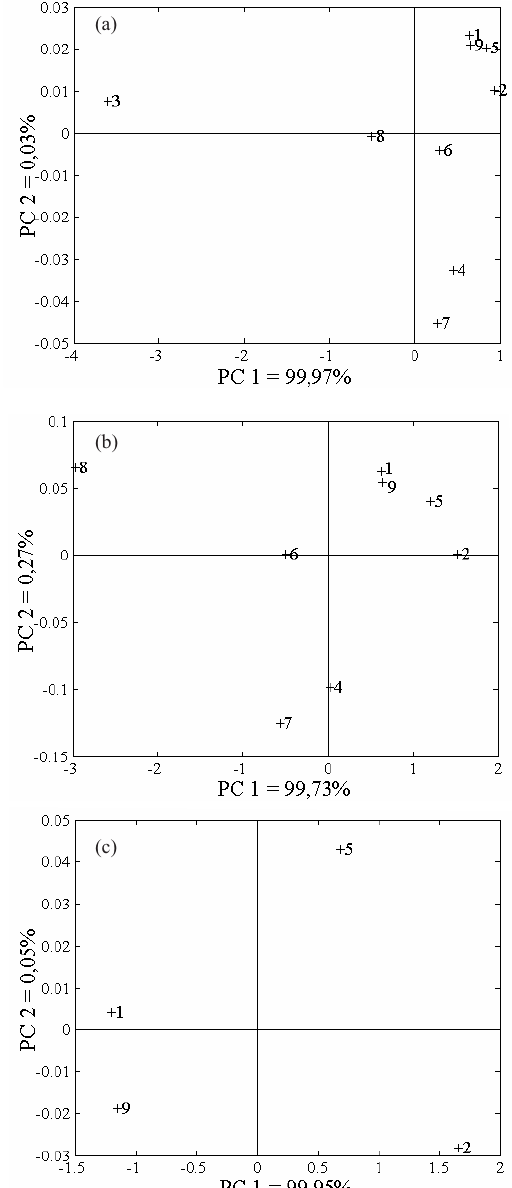
Figura 2. Análise de componentes principais: PC1 × PC2 ( scores ). Analisando todas as amostras (a); todas as amostras, com exceção da 3 (b); e apenas as amostras 1, 2, 5 e 9 (c).